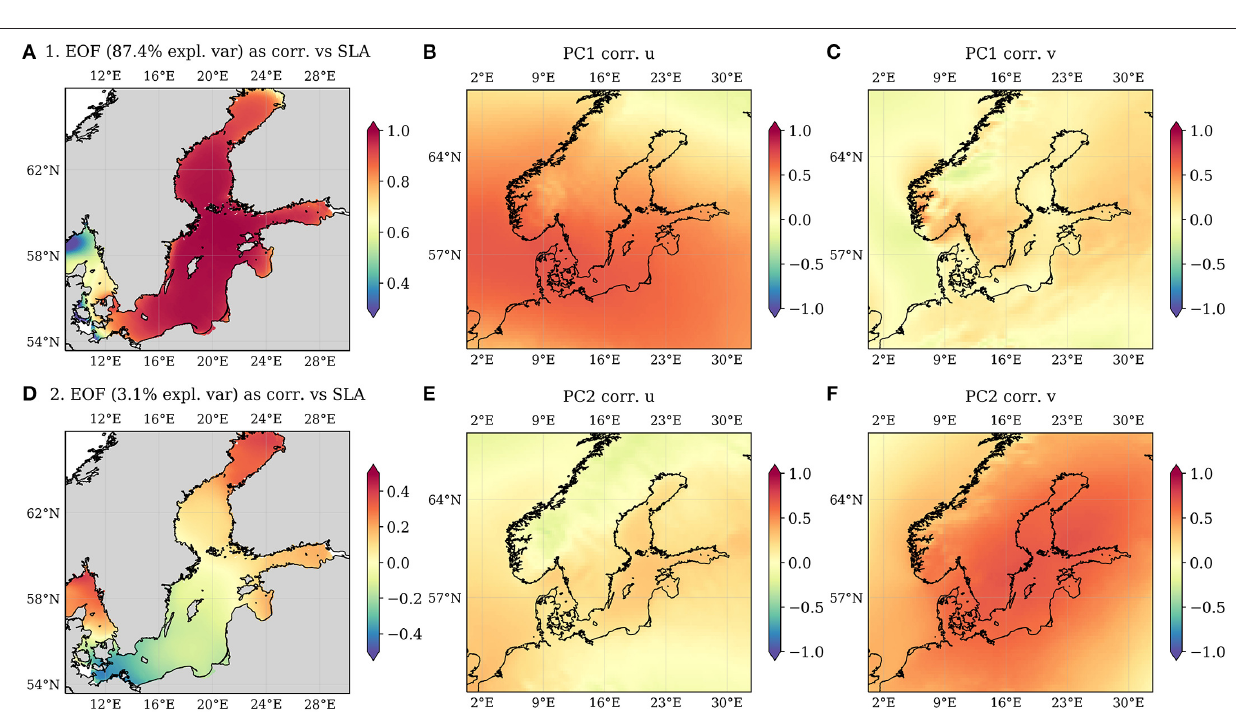
South of the basin, with the correlation degrading toward